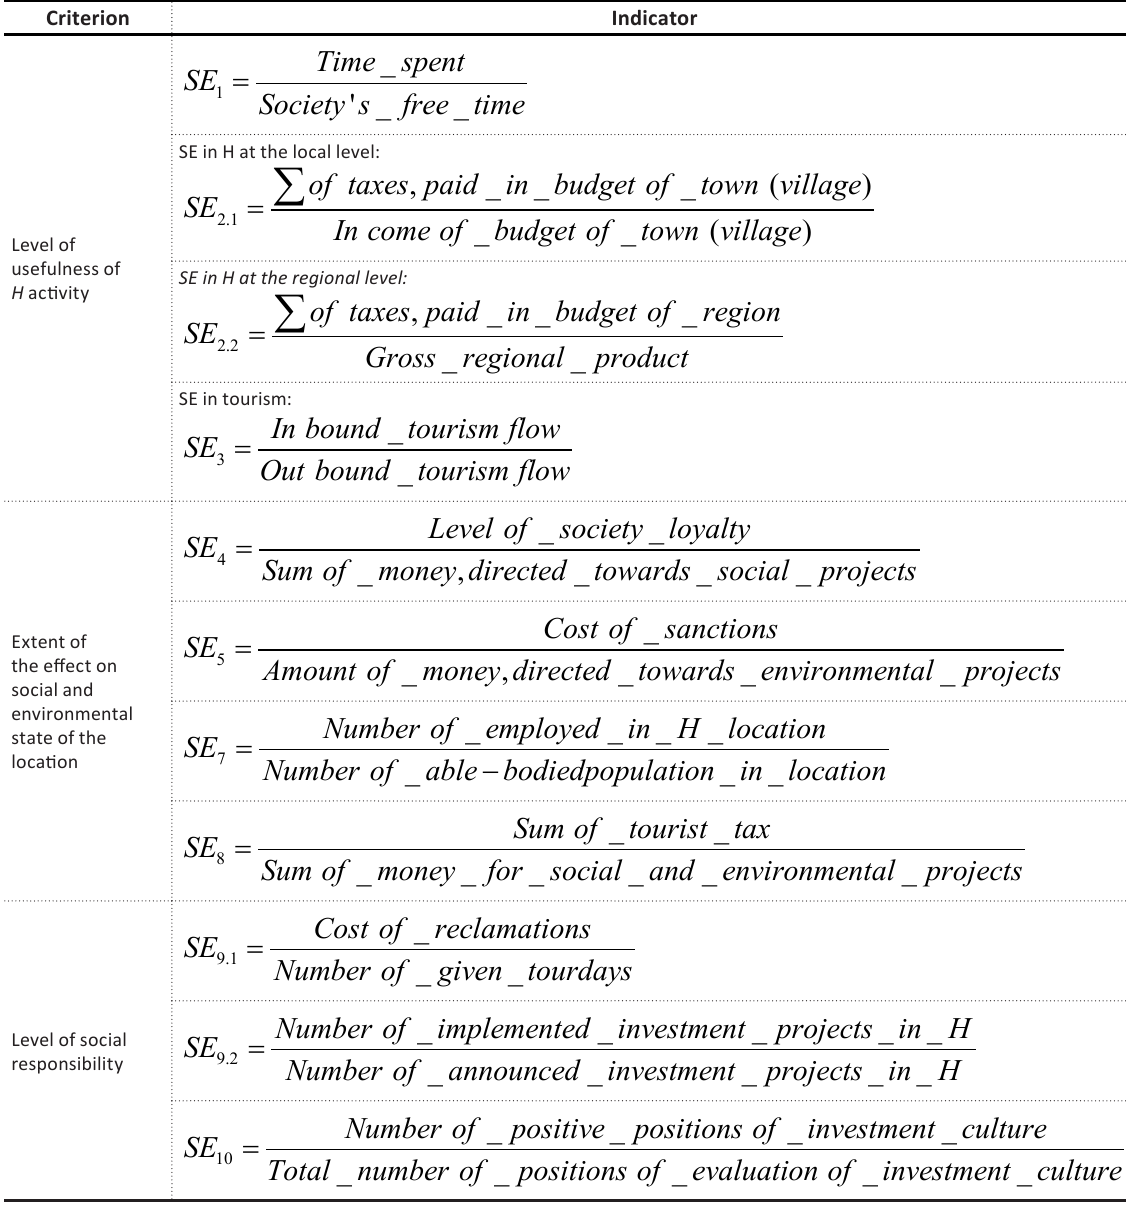
Table 1. Criteria and indicators of social effectiveness ( SE ) effectometry in the hospitality ( H ) Criterion